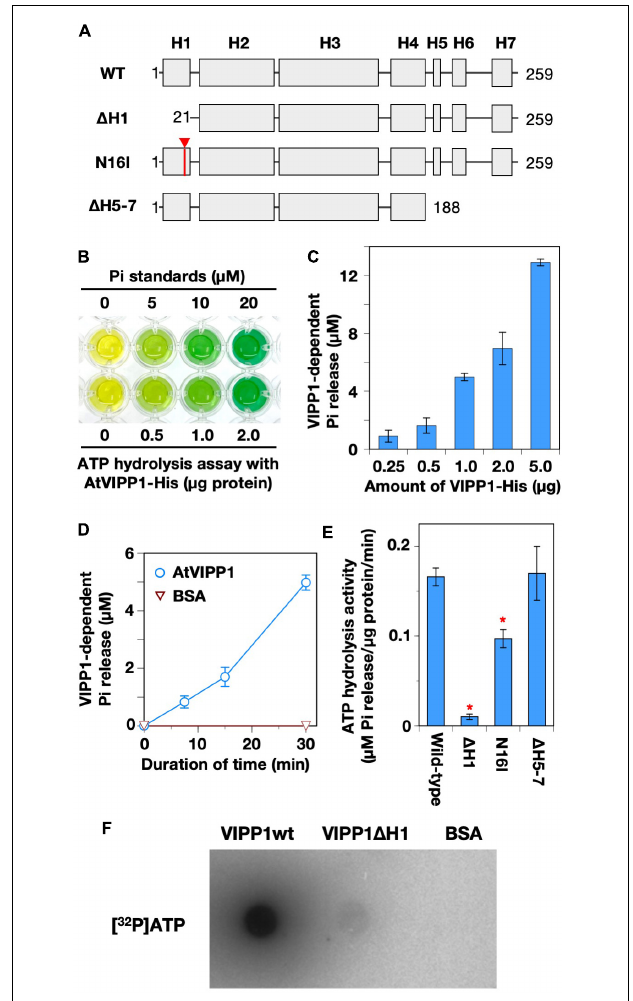
FIGURE 1 | ATP hydrolysis and binding by recombinant AtVIPP1 proteins. (A) Schematic illustration of the secondary structure of Arabidopsis VIPP1 (adopted from Ohnishi et al. (2018)). H indicates a predicted α -helical structure. The numbers indicate the positions of first (left) to last (right) amino acid of the proteins. The mutation site of N16I is approximately indicated by an arrowhead. The detailed sequence of H1 is shown in Supplementary Figure 4 . (B) A photograph of typical a malachite green-based assay for ATP hydrolysis. Green color indicates the presence of free inorganic phosphate (Pi). (C) The level of Pi released from ATP was analyzed using various amounts of wild-type VIPP1 protein (0.25–5.0 µ g in 200 µ L reaction mixture) by the malachite green-based assay. (D) Time-dependent increase in released Pi in the presence of VIPP1-His protein. The reaction mixtures were incubated for 0, 7.5, 15, and 30 min at 37 ◦ C, then free Pi was quantified. Each data point and error bar represents the means and SE, respectively, which were calculated from the results from 4–6 independent experiments. (E) The ATP hydrolysis activity of wild-type, N-terminally, and C-terminally mutated VIPP1-His proteins was analyzed. All the analyses were carried out in standard condition (see Methods). Each bar graph and error bar represents the means and SE, respectively, of results from 4–6 independent experiments. Asterisks denote significant differences in the activity from wild-type proteins (Welch’s t -test with p < 0.01). (F) Direct ATP-binding test of VIPP1-His protein. VIPP1-His, (cid:49) H1, and BSA were dotted on a nitrocellulose membrane and then incubated with radio-labeled ATP ([ α − 32 P]ATP) at room temperature for 1 h. The signals were detected using a BAS1000